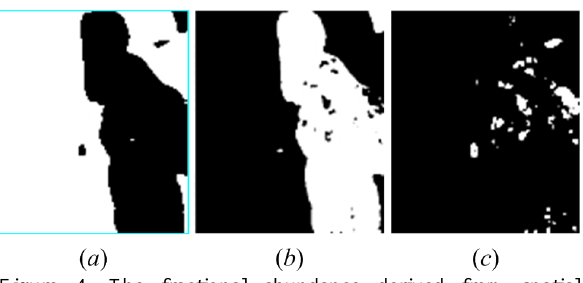
Figure 4. The fractional abundance derived from spatial interpolation-based spectral unmixing, where magnification factor was set to four ( a ) water, ( b ) bare soil / deciduous tree and ( c ) evergreen tree